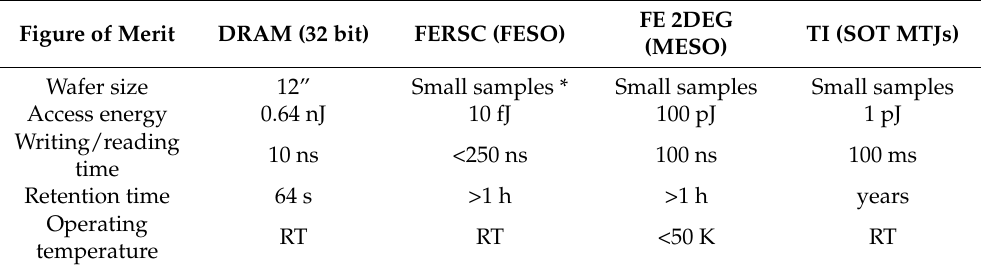
Table 1. Comparison between digital (DRAM) and analog (ferroic-based) strategies for storing the synaptic weight to be used in a neural network for patterning recognition. FE 2DEG Figure of Merit DRAM (32 bit) FERSC (FESO) TI (SOT MTJs) (MESO) Small samples * Small samples Small